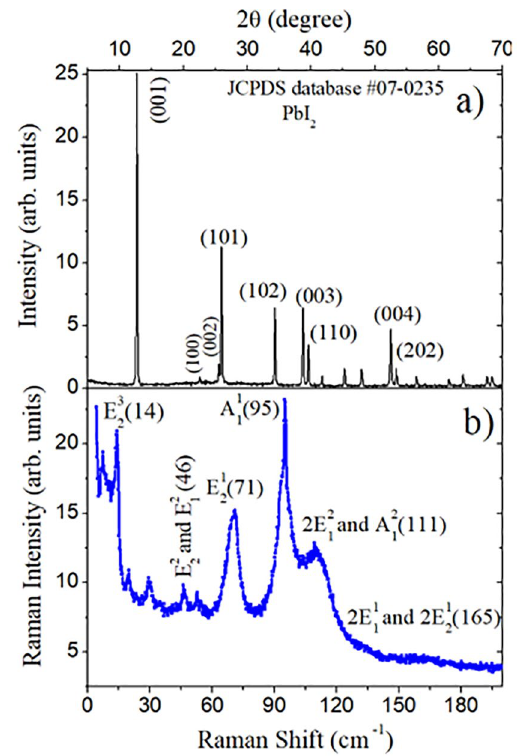
Figure 2. (a) X-ray diffraction and (b) Raman scattering spectra -NPs. obtained from PbI 2